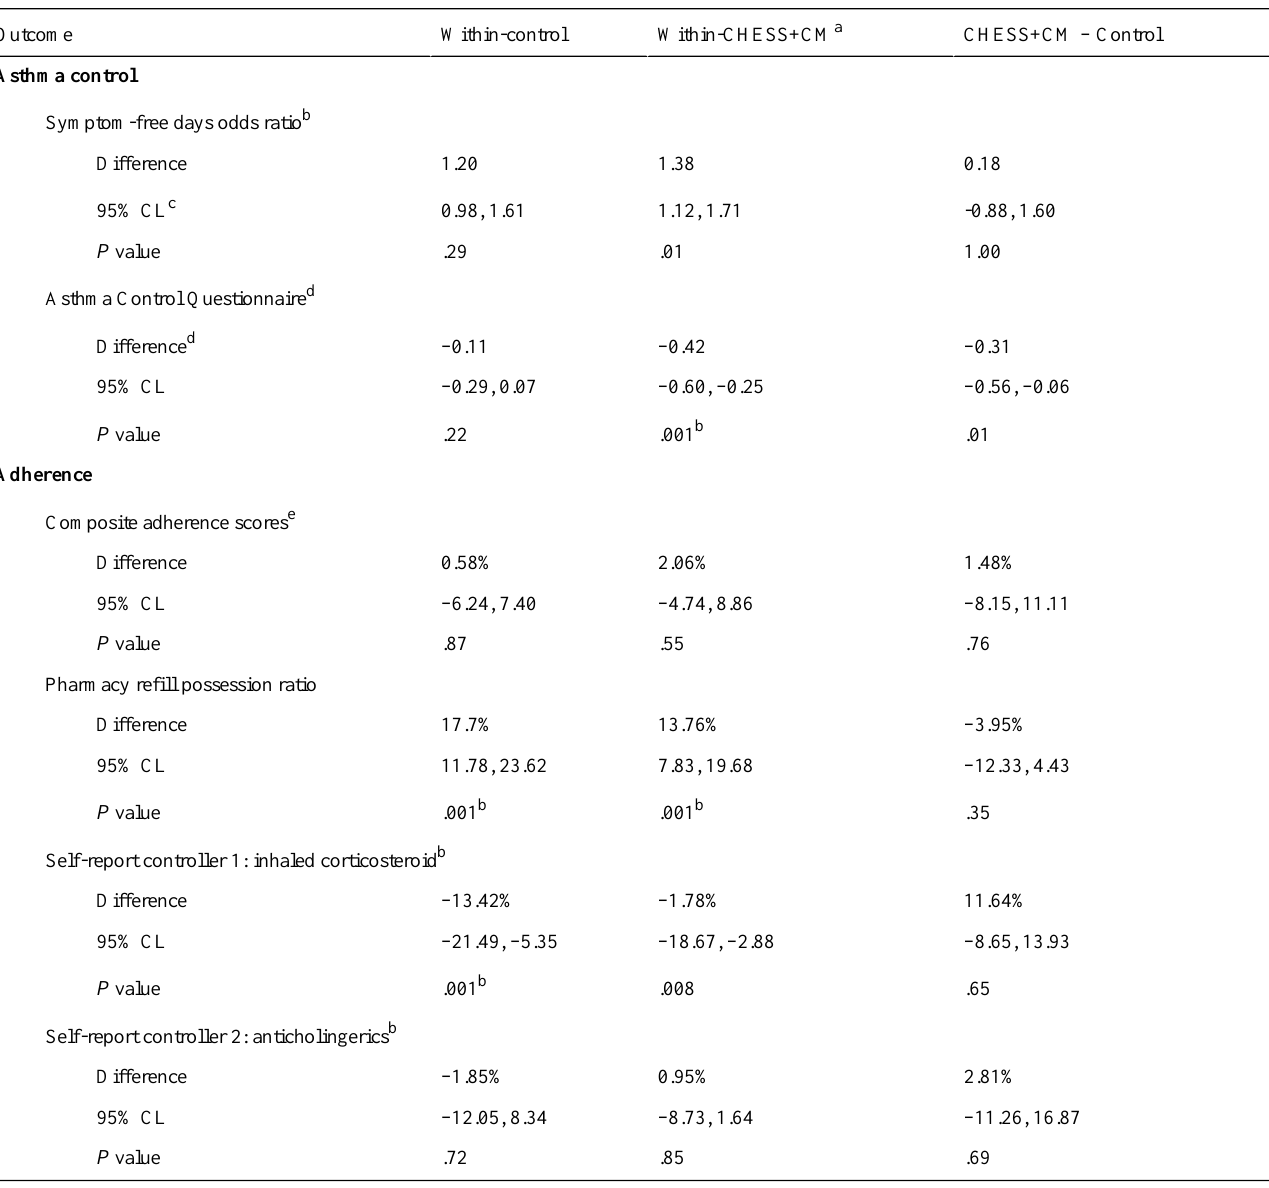
Table 3. Intervention effects: baseline compared with mean of 3-, 6-, 9-, and 12-month scores.